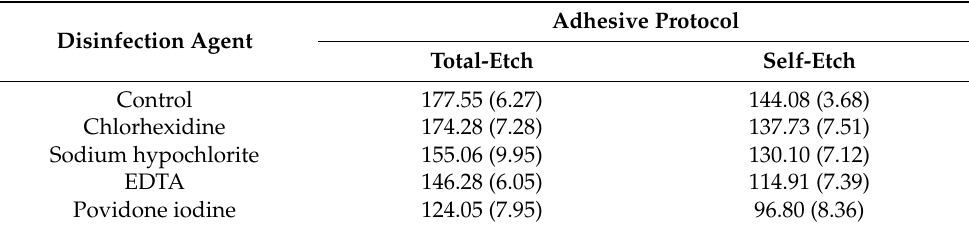
Table 1. Mean micro-shear bond strength (N) of different surface disinfectants in total-etch and self-etch bonding groups.